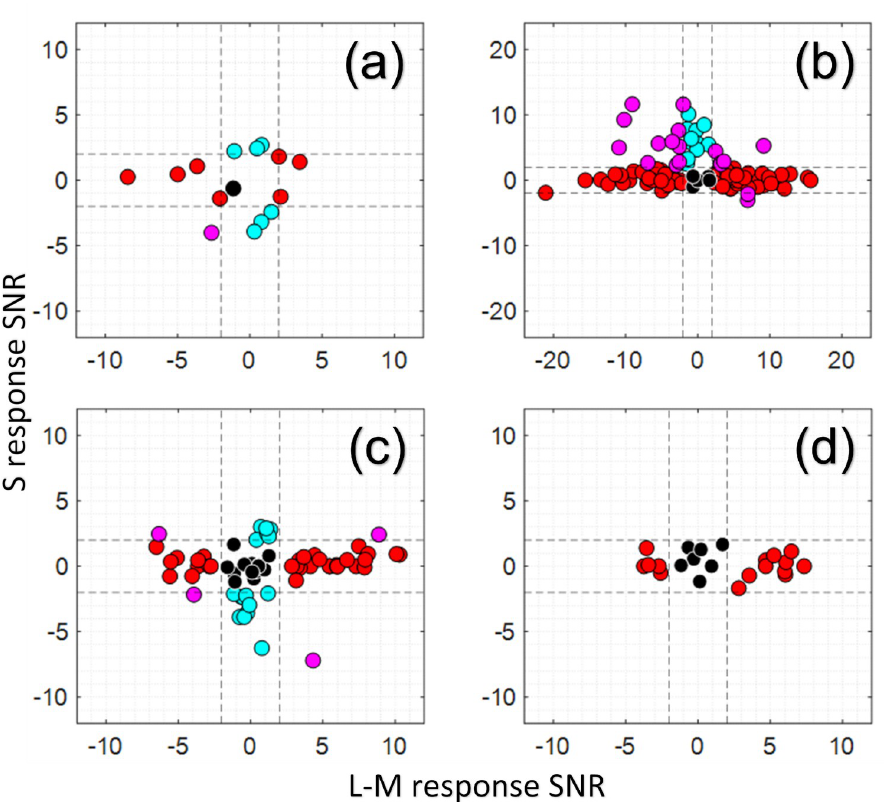
Fig 3. Chromatic response properties of RGCs from three different animals. Black dots show luminance only responding cells, red dots show L-M and M-L cone opponent cells, blue dots show S responding cells, while magenta dots show cells that responded to both L-M and S stimuli. Dotted lines show the significance cutoff of SNR = 2 calculated based on cell responses to the control stimulus (see Methods). Cell response is captured by our signal-to- noise metric described in the Methods. Response phases were also calculated but are not directly shown; however, positive SNRs correspond to responses that were in phase with the stimulus (ON response), while negative SNRs correspond to responses that were approximately 180 deg out of phase with the stimulus (OFF response). The luminance axis is perpendicular to the plane shown and is not included for readability and because not all cells responded to the luminance stimulus. Luminance only cells shown in black thus include both ON and OFF cells. In (a) , responses from 15 cells in M1 are shown after presentation of spatially uniform luminance, L-M isoluminant and S-isolating stimuli at 0.2 Hz. In (b) , responses from 126 cells in M2 are shown after presentation of spatially uniform luminance, L-M isoluminant and S-isolating stimuli at 0.2 Hz. In (c) , responses from 83 cells (a subset of the cells in Fig 4A, does not contain any cells from Fig 3D) in M3 are shown after presentation of spatially uniform luminance, L- isolating, M-isolating, and S-isolating stimuli at 0.15 Hz. In (d) , responses from 22 cells (a subset of the cells in Fig 4D) serving the very central fovea of M3 are shown after presentation of spatially uniform luminance, L-isolating, M- isolating, and S-isolating stimuli at 0.15 Hz. These cells are closer to the foveal center than any of the cells shown in (c). In (c-d) , all stimuli were single-cone isolating, so the L-M axis is calculated from the single cone L-isolating and M- isolating responses and their relative